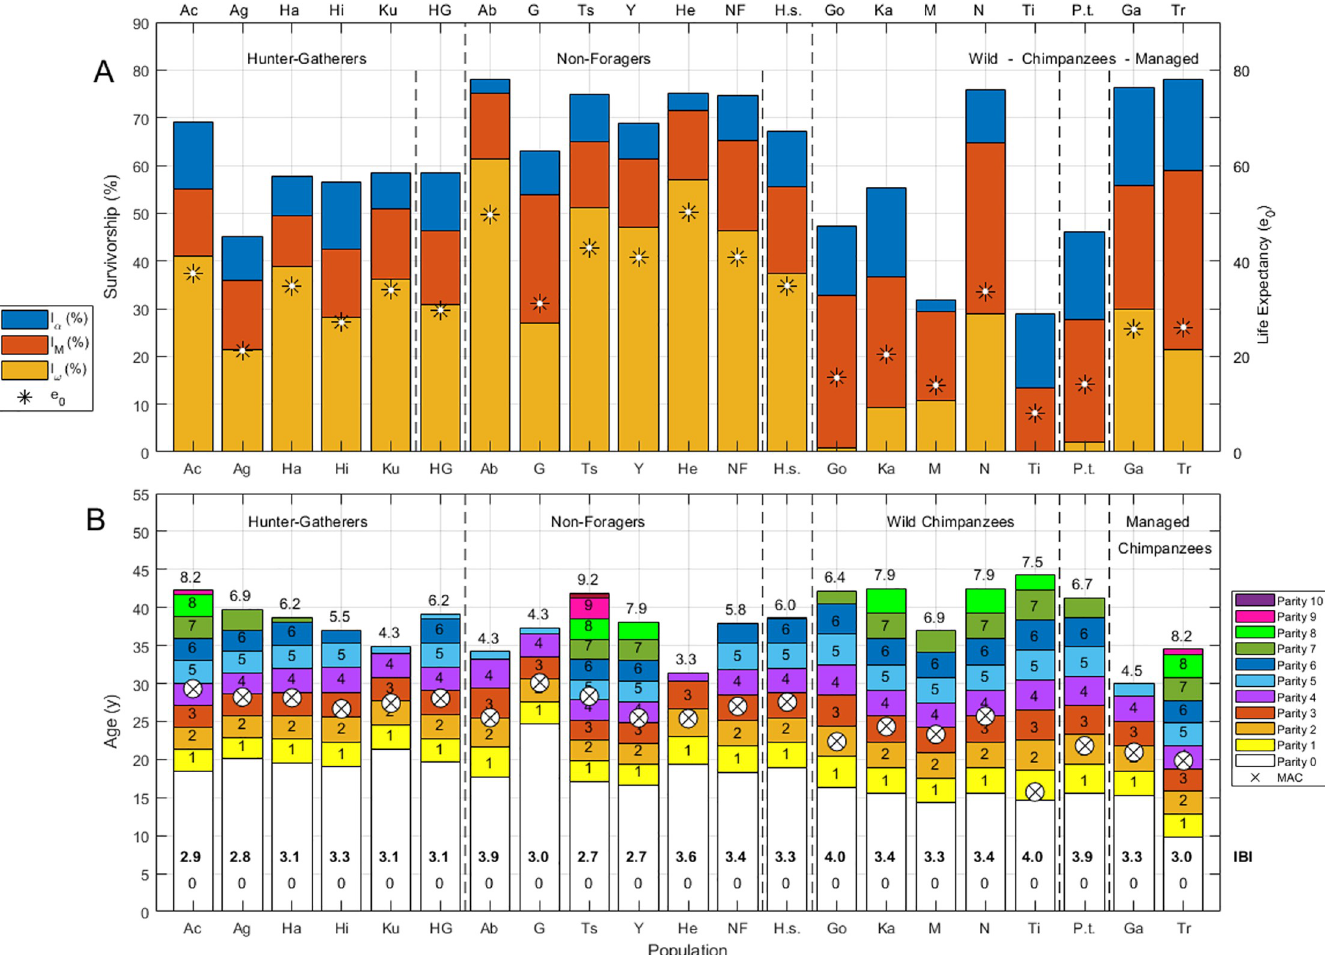
Fig 2. Summary of demographic measures for chimpanzee and human populations. (A) Stacked bars indicate survivorship (%) to maturity ( l α ), to mean age of reproduction ( l M ) and to maximum age of reproduction ( l ω ); life expectancy ( e 0 ) is indicated by a large asterisk. (B) Stacked bars indicate rough ages at each parity from zero (nulliparous) to the total fertility rate ( TFR ) estimated for each population. Parity is indicated by inset text in each stacked bar, TFR is indicated above each bar and the mean interbirth interval ( IBI ) is in bold text inset in the lowest (nulliparous) bar. Vertical dashed lines separate Hunter-gatherers (HG), Non-Foragers (NF) and Wild Chimpanzees (WC). Hunter-gatherers are labeled: Ac (Ache), Ag (Agta), Ha (Hadza), Hi (Hiwi), Ku (Ju/’hoansi! Kung), hunter-gatherer mean life history (HG). Non-foragers are labeled: Ab (Aborigines), G (Gainj), Ts (Tsimane), Y(Yanomamo), He (Herero), non-forager mean life history (NF). Chimpanzee populations are labeled: Go (Gombe), Ka (Kanyawara), N (Ngogo), Ti (Ta ï ), wild chimpanzee mean life history (WC), Ga (Gambia), Tr (Taronga).